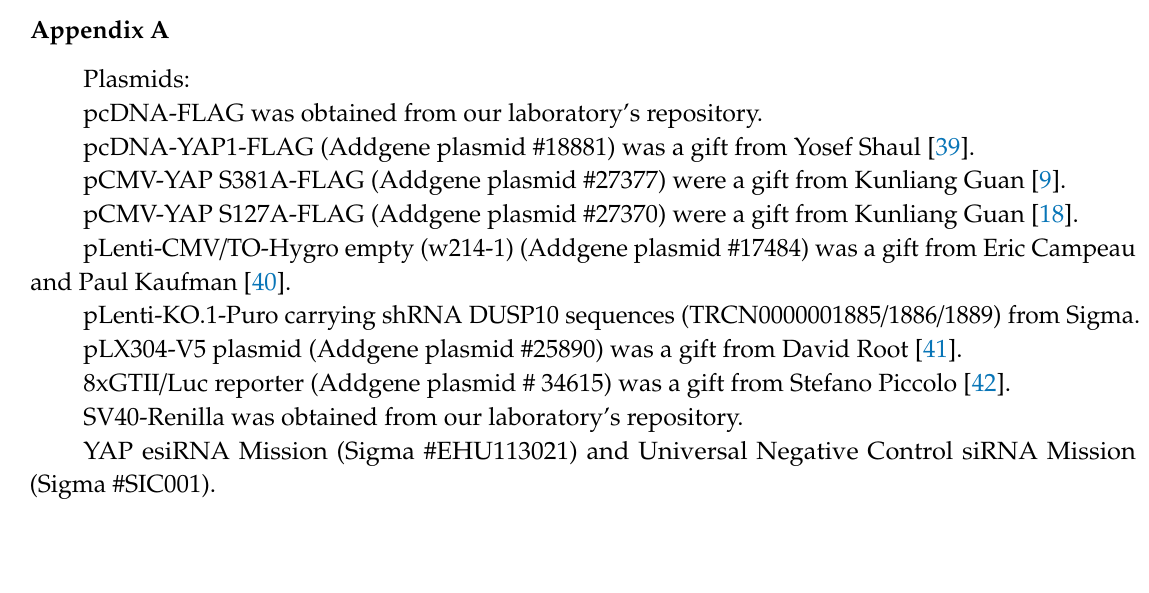
Figure S1: DUSP10 expression regulates p38 dephosphorylation in HT29lucD6 cell line, Figure S2: DUSP10 overexpression in HCT116 cell line promotes in vitro and in vivo growth, Figure S3: High density e ff ects in HCT116 cell line, Figure S4: Immunofluorescence staining for YAP1 protein at low and high density in CRC cell lines, Figure S5: A YAP inhibitor in preventing DUSP10-enhanced proliferation in CRC cell line, Figure S6: Transient transfection of YAP and DUSP10 mutant plasmids in HCT116, Figure S7 : In silico analysis of